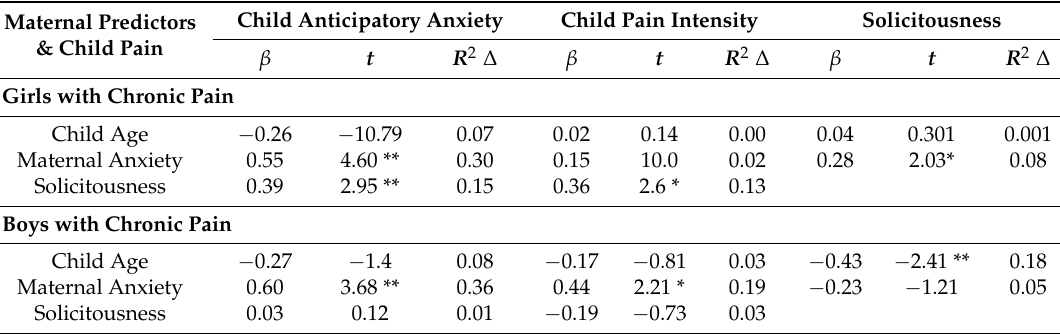
Table 4. Regression models for pre-conditions of mediation.